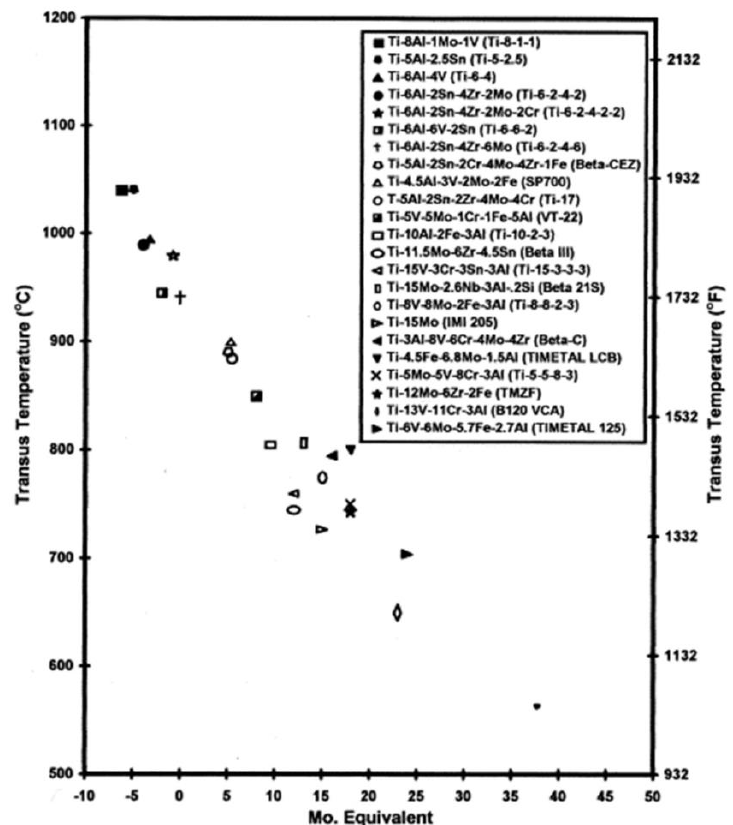
Figure 3. The beta transus temperature, T β , plot as a function of molybdenum equivalency (MoE) for select alloys. The quantity T β exhibits a generally decreasing trend with increasing MoE value [58]. (Reprinted by permission from Materials Science and Engineering A, vol. 243, no. 1–2, I. Weiss and S. L. Semiatin, Thermomechanical processing of beta titanium Alloys—an overview, 46–65, 1998, with permission from Elsevier).